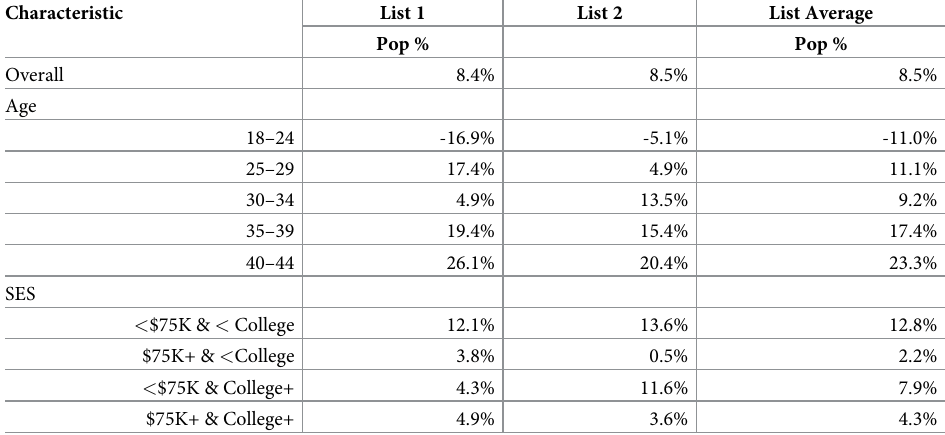
Table 4. Percent of the population that reported abortion utilization using the indirect measure between and across the lists in the Ohio Survey of Women (n = 2529).